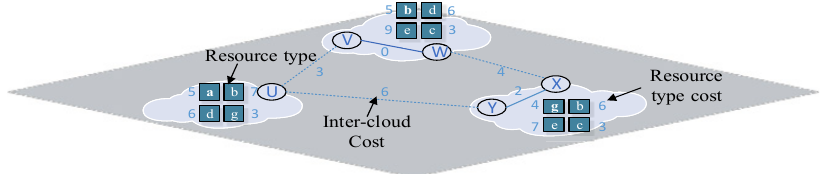
Fig. 4. The Broker's View on the Multi-Cloud